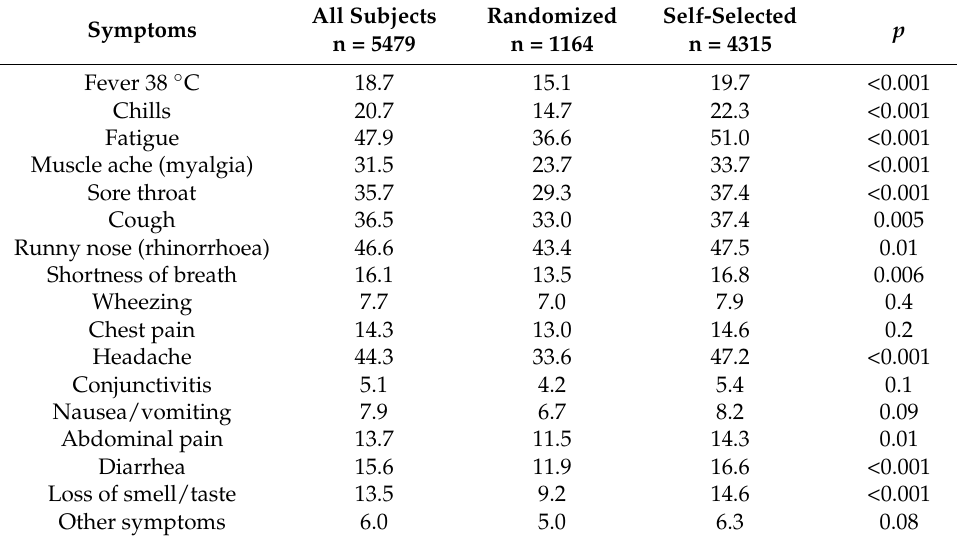
Table 3. Results of epidemiological interview, including prevalence of declared symptoms (percent- ages) with p -values of difference tests.